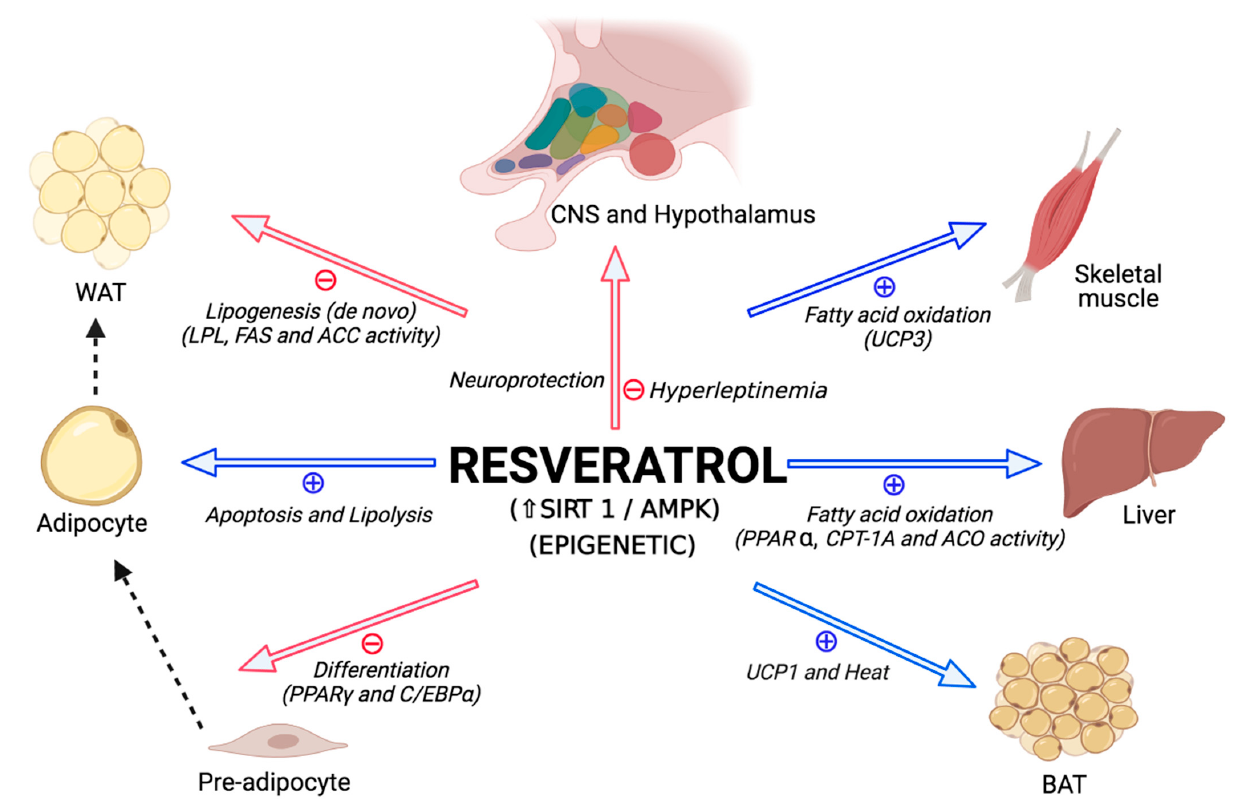
Figure 2. Proposed metabolic effects of resveratrol. ACC: acetyl-CoA carboxylase; ACO: acyl-CoA oxidase; AMPK: AMP- activated protein kinase; BAT: brown adipose tissue; C/EBP: CCAAT/enhancer-binding protein; CNS: central nervous system; CPT: carnitine palmitoyltransferase; FAS: fatty acid synthase; LPL: lipoprotein lipase; PPAR: peroxisome proliferator- activated receptor; SIRT: sirtuin; UCP 1 and 3: uncoupling protein 1 and 3, respectively; WAT: white adipose tissue. The red arrows represent inhibition and the blue arrows stimulation. The dashed black line indicates the direction of tissue changes. Figure modified from Aguirre L. et al. [20]. Created in BioRender.com.